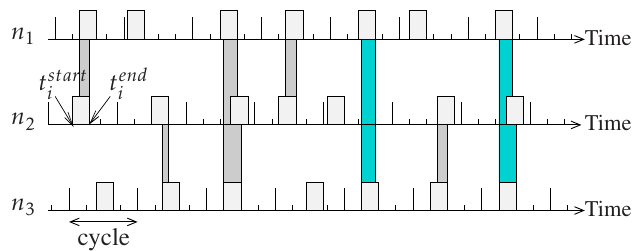
Figure 2. Example of the activities of three neighbor nodes with the SLACK-MAC protocol, with a duty-cycle of 25% (again, this long duty-cycle is chosen for